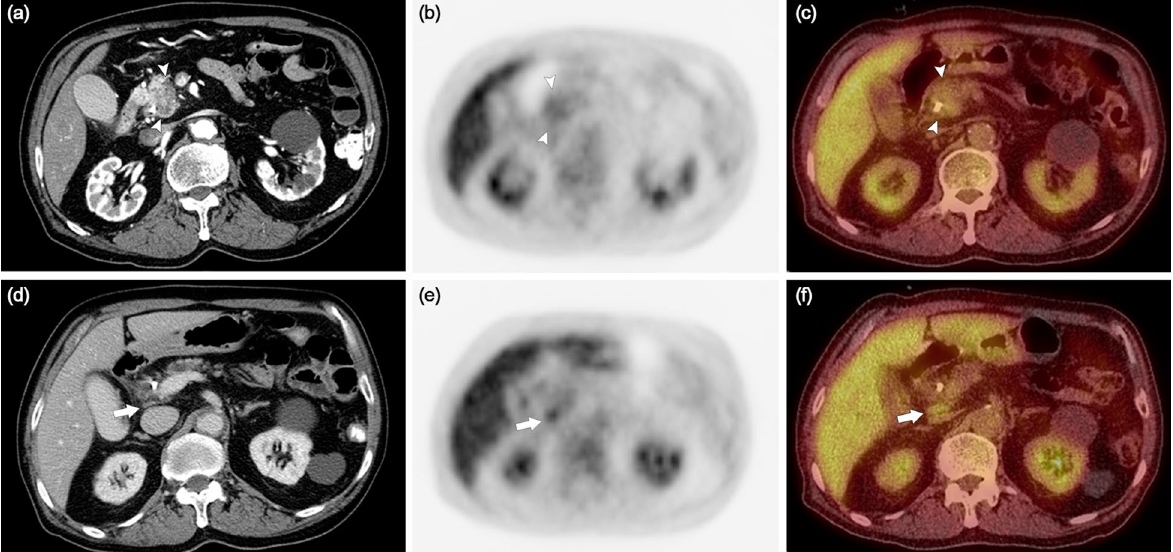
Figure 3. Contrast-enhanced dynamic computed tomography (CT) and 18 F-fluoro-2-deoxyglucose-positron emission tomography (FDG-PET) scans of a 76-year old male patient diagnosed with pancreatic head cancer. A 2.7 cm sized hypoattenuating mass (arrowheads) is noted on the arterial phase of the CT ( a ), which shows significant FDG uptake on the FDG-PET ( b ) and FDG-PET/CT scans ( c ). A small lymph node (LN) was noted in the portocaval space (arrow) on the venous phase of the CT ( d ), with significant FDG uptake on the FDG-PET ( e ) and FDG-PET/CT scans ( f ). The patient was categorized as positive regional LN metastasis by the LN OR definition, but negative regional LN metastasis by the LN AND definition. After pylorus-preserving pancreaticoduodenectomy and regional LN dissection, regional LN metastasis was confirmed. Early local recurrence was identified on CT and FDG-PET scans performed 10.5 months after surgery. Patient expired 15.9 months after